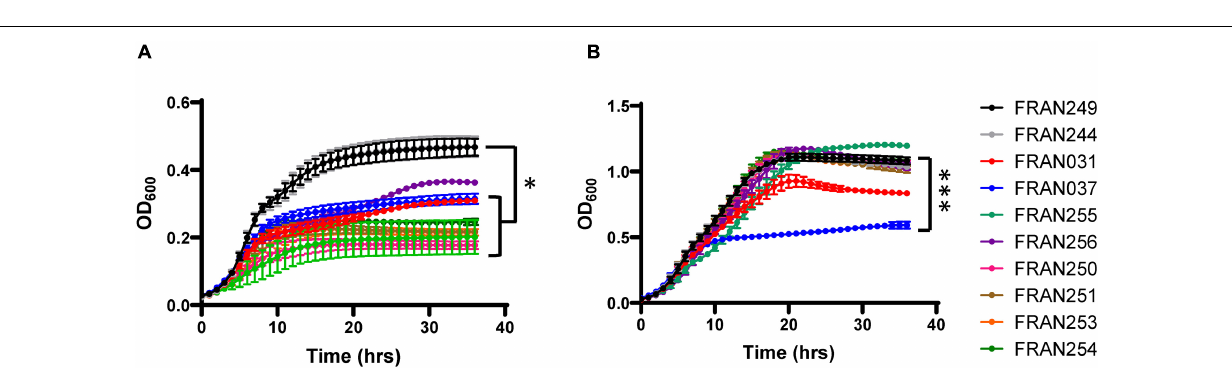
FIGURE 5 | Growth assays in BHI broth and CDM. The 10 F. tularensis strains were grown in BHI containing 1% Isovitalex (A) or CDM (B) at 37 ◦ C, and growth was monitored by optical density. OD 600 measurements were based upon quadruplicate samples and the experiment was repeated three times. The graphs show the average of these three experiments. Error bars represent standard error of the mean. ∗ P < 0.05 for FRAN249 and FRAN244 compared to all other strains with the exception of FRAN256 (A) , and ∗∗∗ P < 0.001 for FRAN249 and FRAN244 compared to FRAN037 (B)